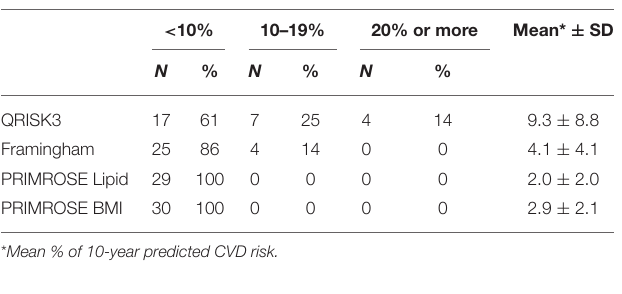
TABLE 3 | Ten-year predicted CVD risk scores according to 4 different risk calculators.